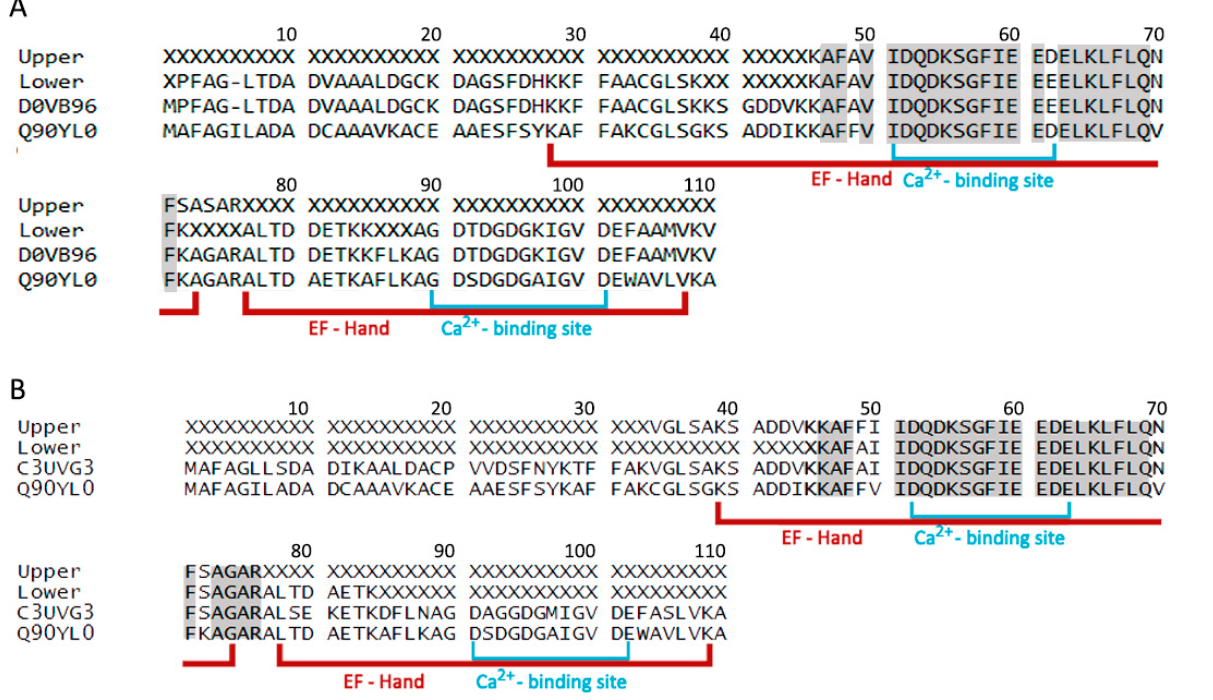
Figure 1. Parvalbumin sequences of gilthead seabream ( A ) and European seabass ( B ) obtained from positive bands presented in Figure S1, in comparison to the available sequence of gilthead seabream (Uniprot D0VB96), European seabass (C3UVG3) and cod parvalbumin (Q90YL0). Grey areas represent homology between sequences and X represents no MS identification. EF-Hand motifs and Ca 2+ -binding site are shown by red and blue lines, respectively.